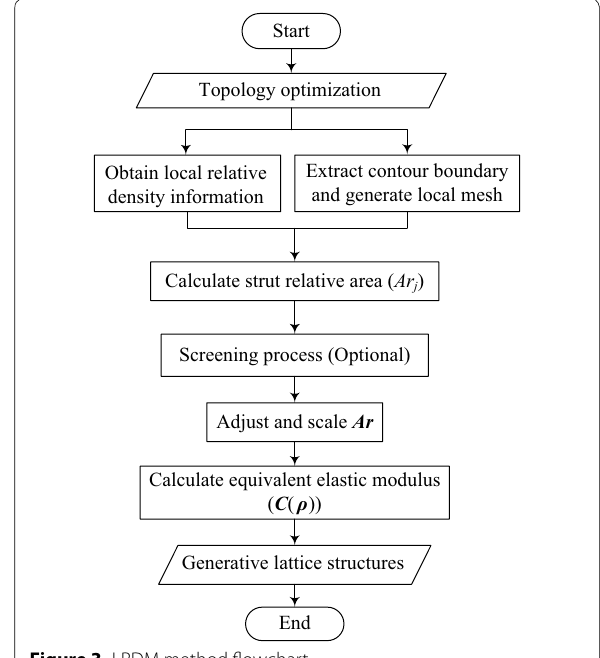
Figure 3 LRDM method